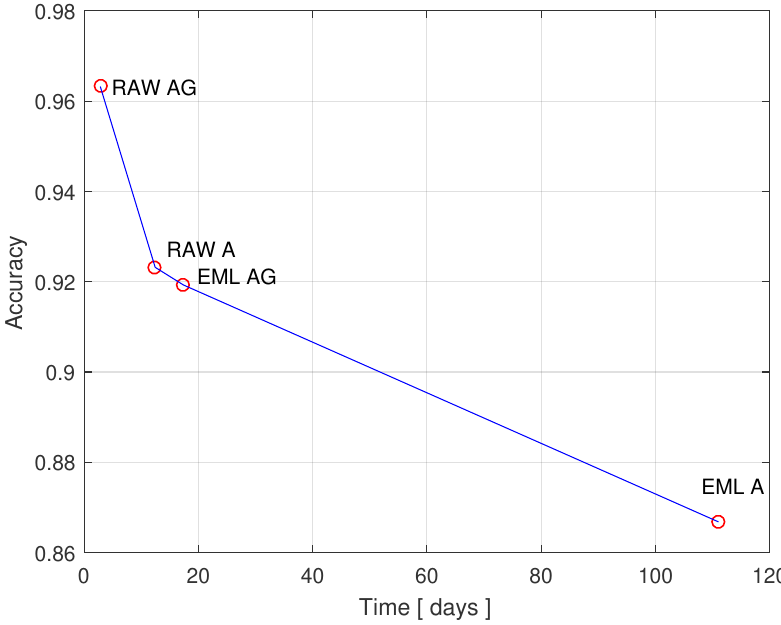
Figure 5. The trade-off between the model accuracy and lifetime. Legend: